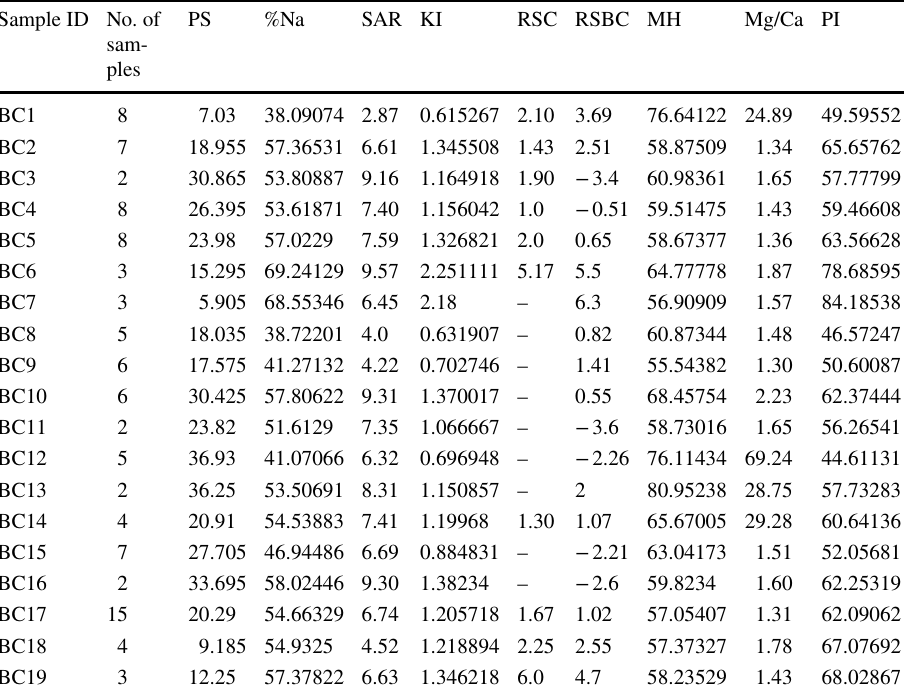
parameters (mean values in meq/l) of groundwater